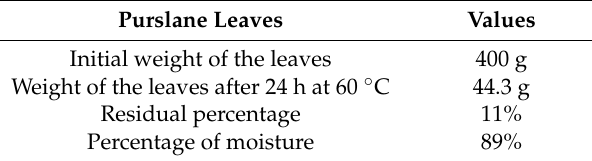
Table 1. Determination of some values on the leaves of purslane before and after drying.